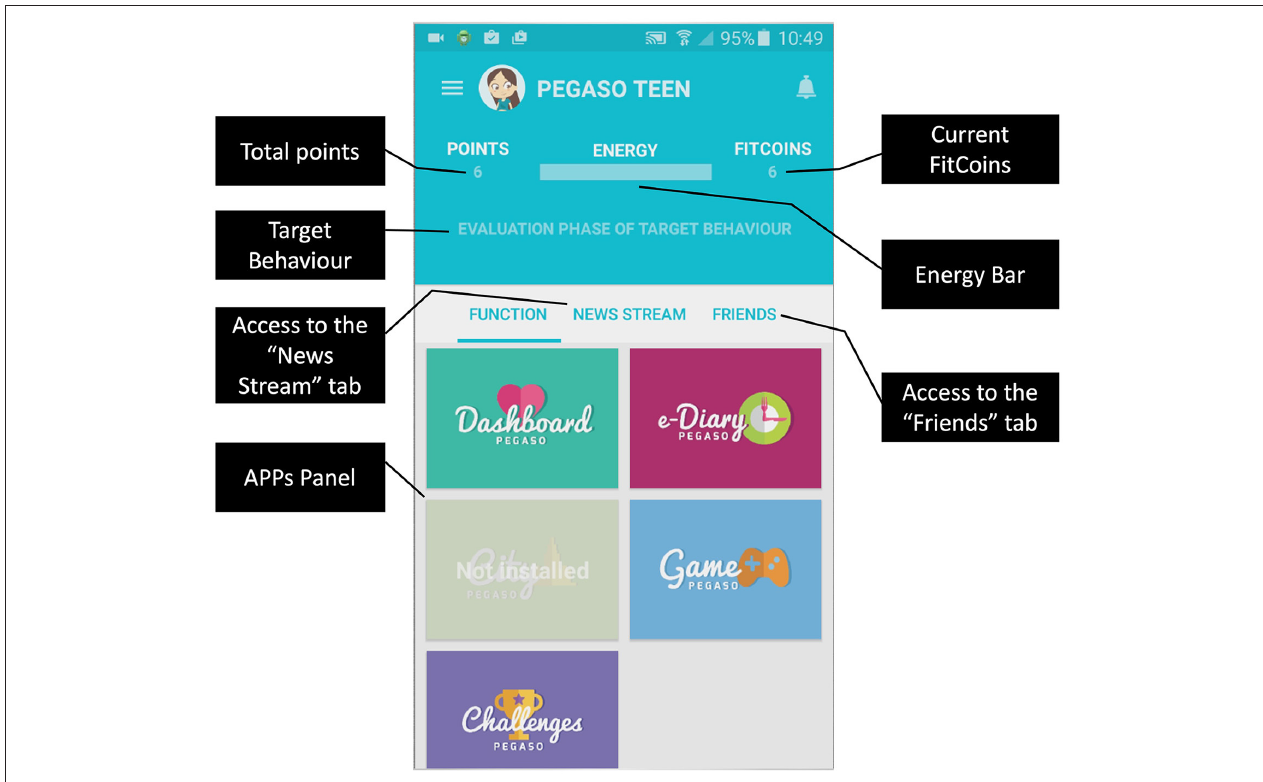
FIGURE 5 | Companion app